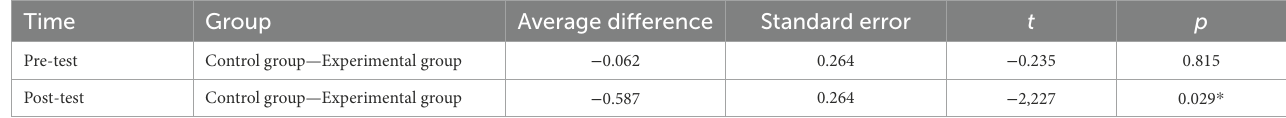
TABLE 4 Simple effects analysis of study engagement group between experimental group and control group before and after intervention. Time Group Pre-test